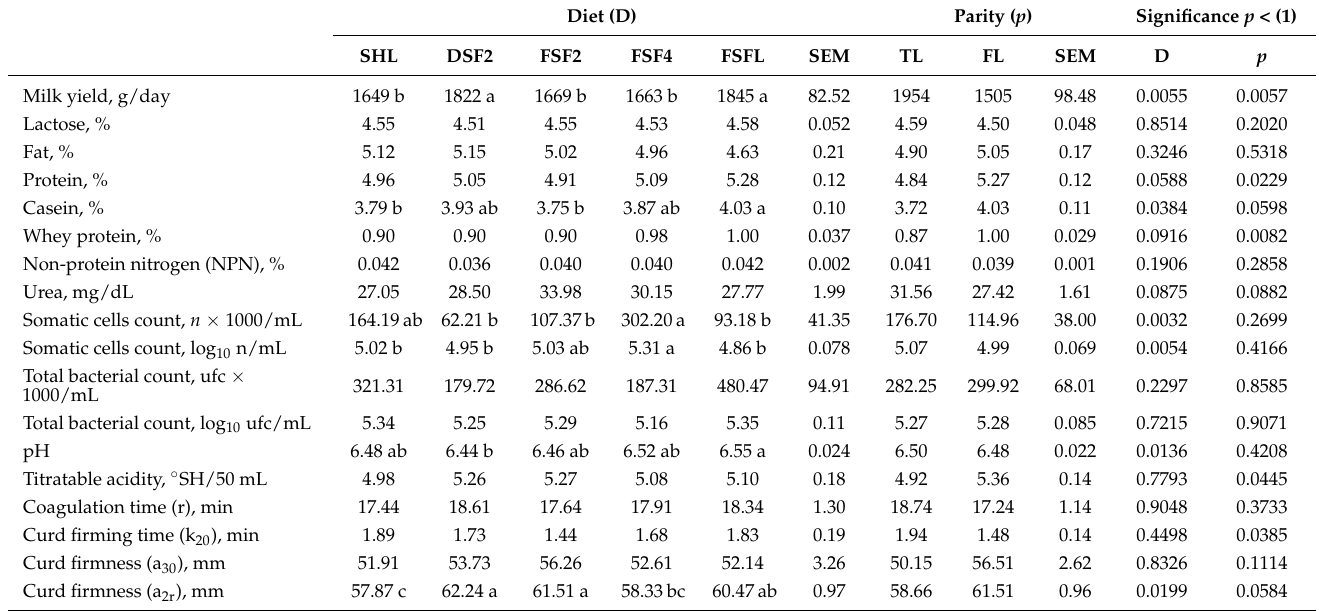
Table 1. The effect of diet and parity on production, composition and coagulation properties of individual milk used for micro